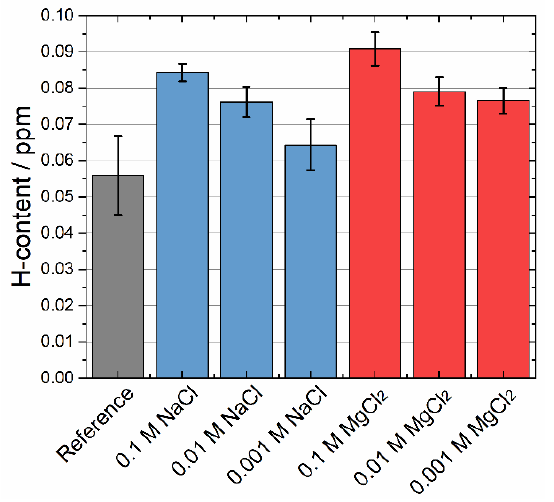
Figure 5. Hydrogen content after first drying interval determined with TDMS.